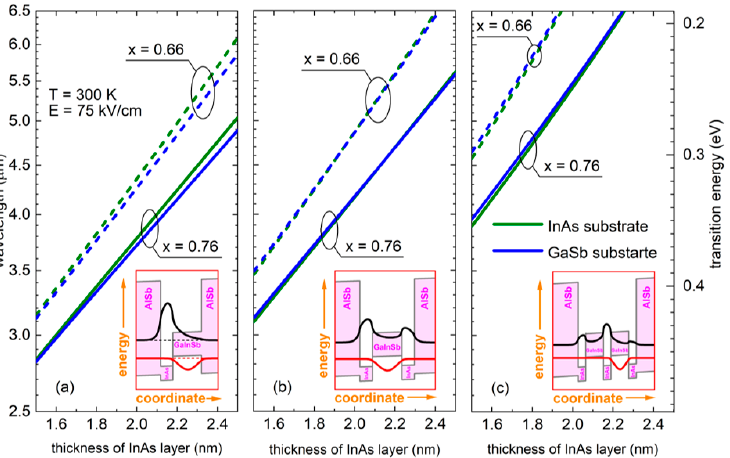
Figure 1. Fundamental transition energy in the active region of AlSb/InAs/Ga x In 1 − x Sb/AlSb ( a ), AlSb/InAs/Ga x In 1 − x Sb/InAs/AlSb ( b ) and AlSb/InAs/Ga x In 1 − x Sb/InAs/Ga x In 1 − x Sb/InAs/AlSb ( c ), as a function of the InAs well width. Two different values of the Ga content in Ga x In 1 − x Sb are used: 66% (dashed line) and 76% (solid line). Blue and green lines refer to structures deposited on GaSb and InAs, respectively. The Ga x In 1 − x Sb layer thickness is 3.5 nm. The insets show the confinement potential profiles, energy levels and carrier probability densities in the external electric field.